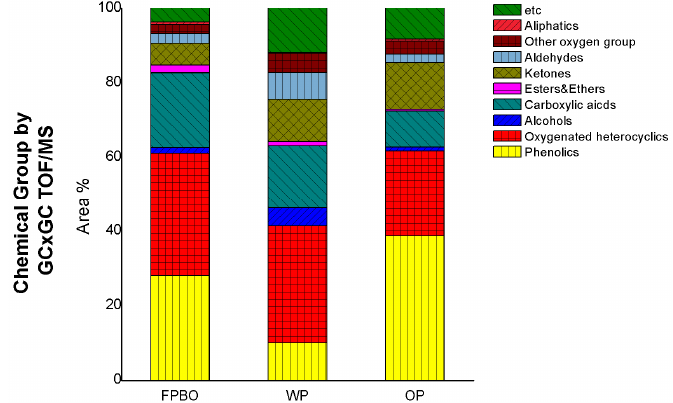
Figure 4. Chemical group compositions of FPBO, WP, and OP.